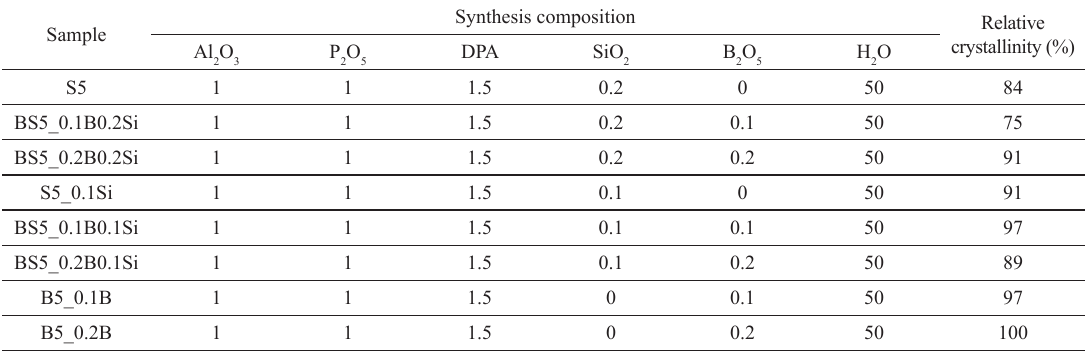
Table 1. Coding, composition and relative crystallinity of samples of the AFI structure.